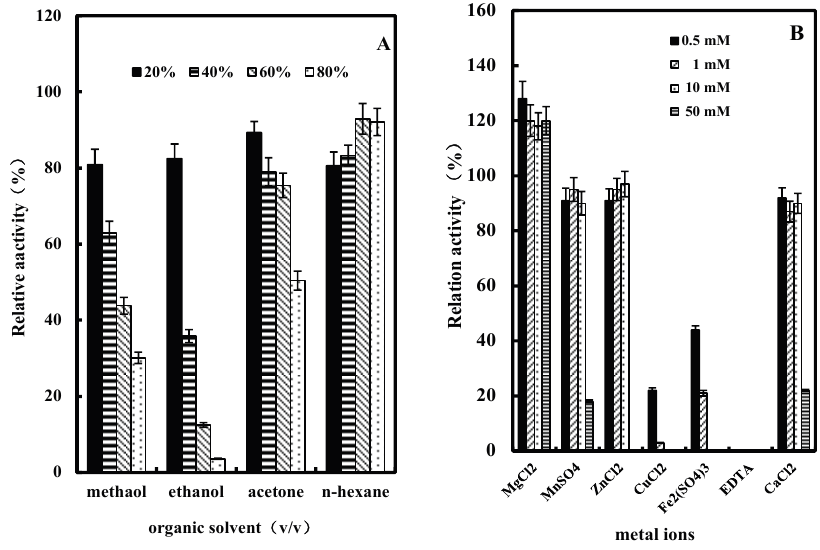
Figure 7. Effects of organic solvents and metal ions on the activity of purified GlcDH from A. globiformis C224. ( A ) Effect of organic solvents on the activity of purified GlcDH, organic solvents concentrations: 20%, 40%, 60% and 80% (v/v); ( B ) Effect of metal ions